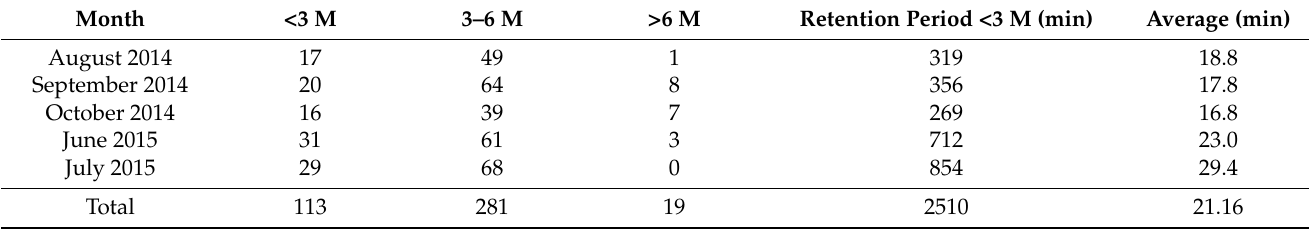
Table A1. Lastovo island—density, distance and retention period of cruise ships’ traffic in selected high-risk navigational and environmental region.